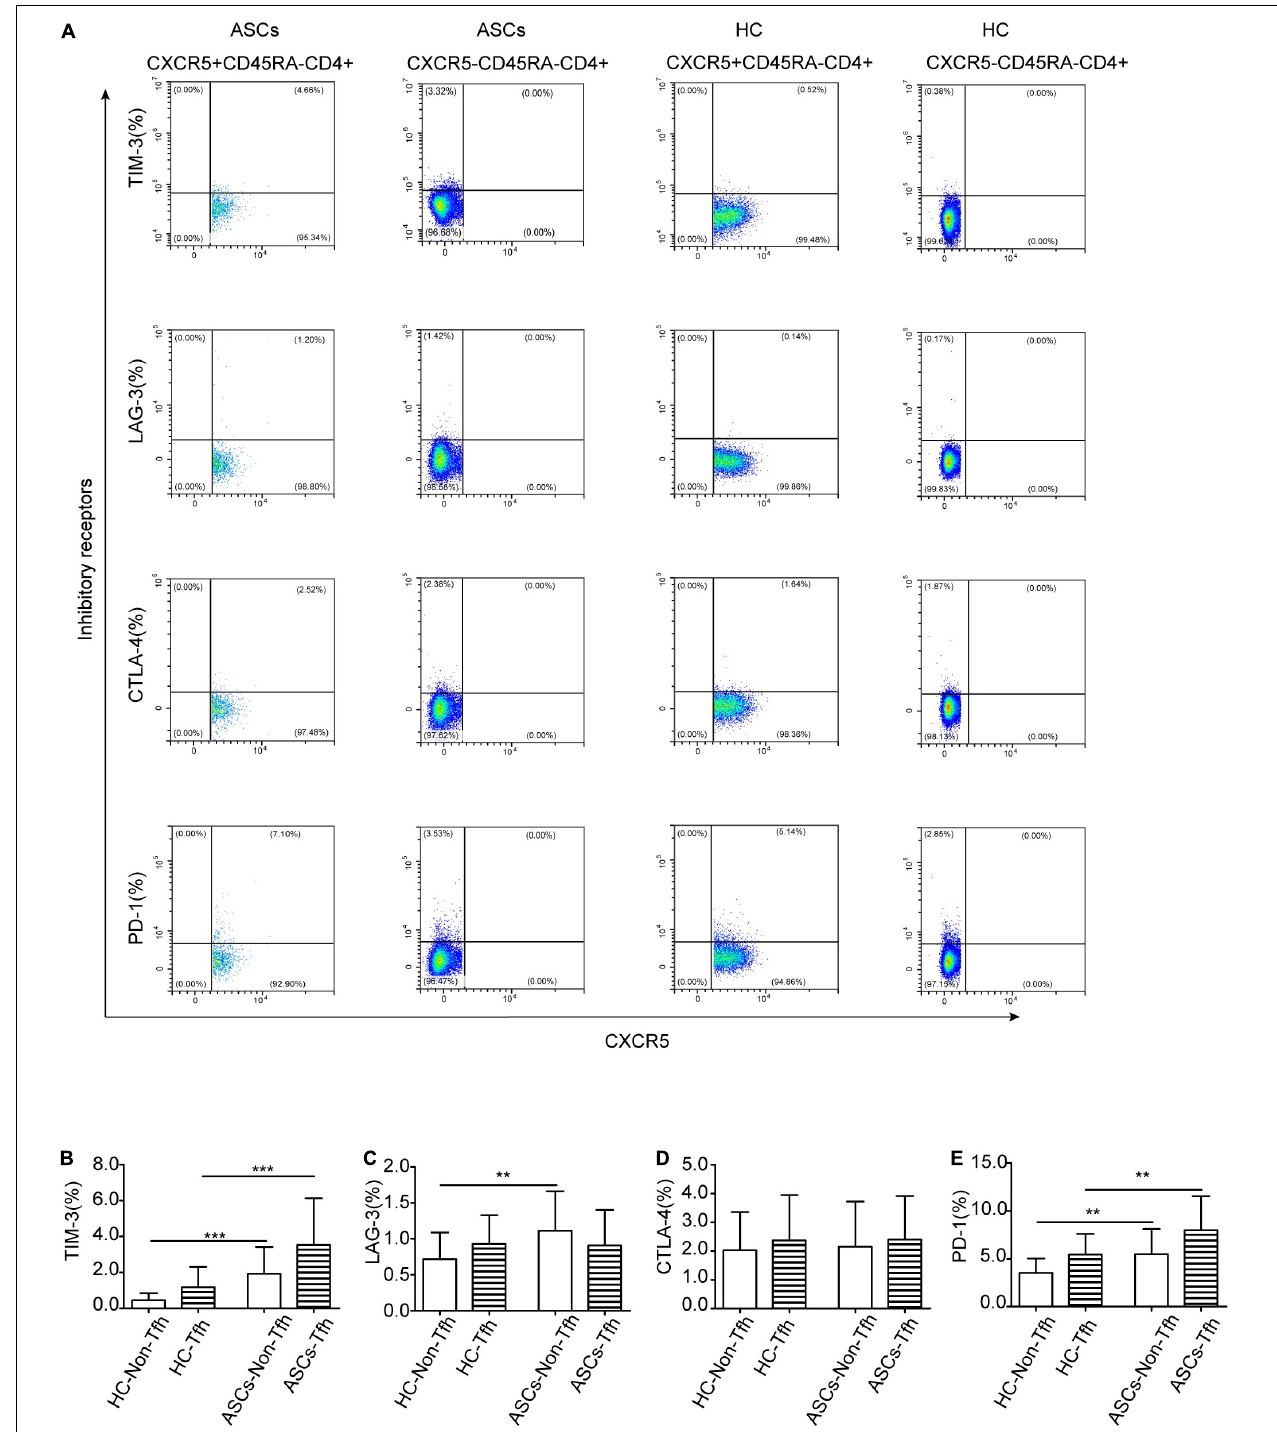
FIGURE 2 | Immune checkpoint molecules expressed on CXCR5 + CD45RA − CD4 + Tfh cells. (A) Flow cytometry detection of PD-1 + , TIM-3 + , LAG-3 + , and CTLA-4 + on CXCR5 + CD45RA − CD4 + Tfh cells and CXCR5 − CD45RA − CD4 + Th cells in ASCs and HC. (B–E) Analysis of the expression of PD-1 + , TIM-3 + , LAG-3 + , and CTLA-4 + on CXCR5 + CD45RA − CD4 + Tfh cells and CXCR5 − CD45RA − CD4 + Th cells in ASCs and HC. Data represent the mean ± SD. ** P < 0.01, *** P <